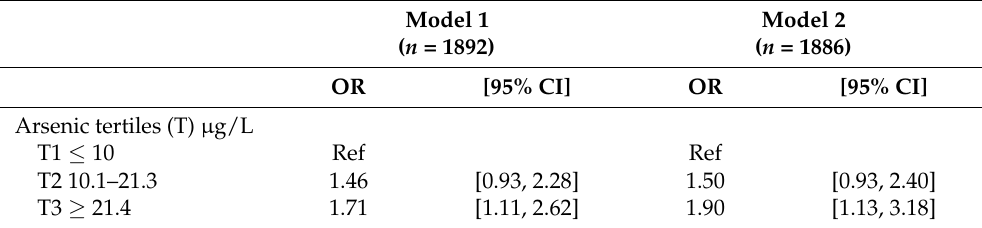
Table 3. Association between asthma and urinary arsenic concentration, Arica (2009–2021).